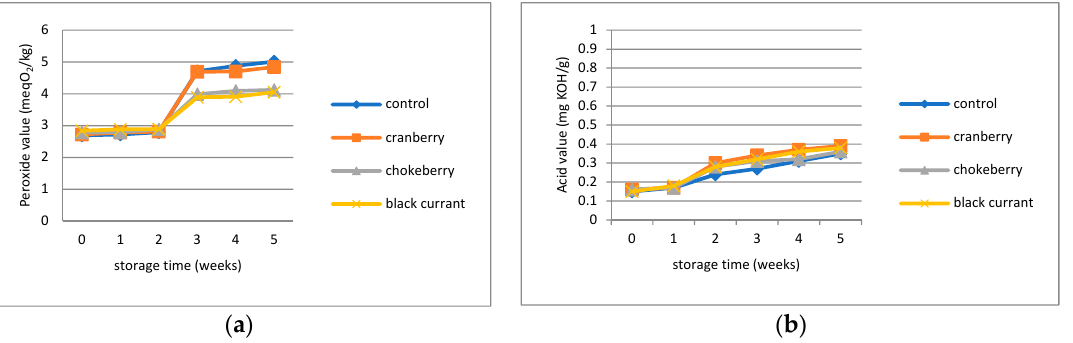
Figure 2. Changes of ( a ) peroxide value and ( b ) acid value of the fat extracted from the fried snacks during storage for 5 weeks.